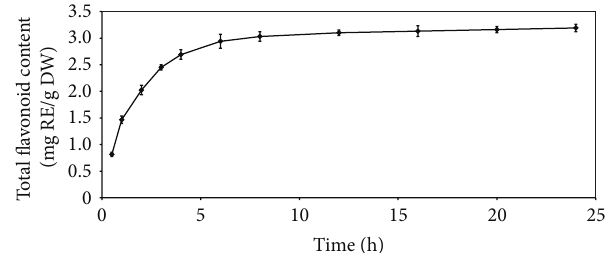
Figure 2: The total extracted flavonoid content when macerating apple samples at different time intervals.